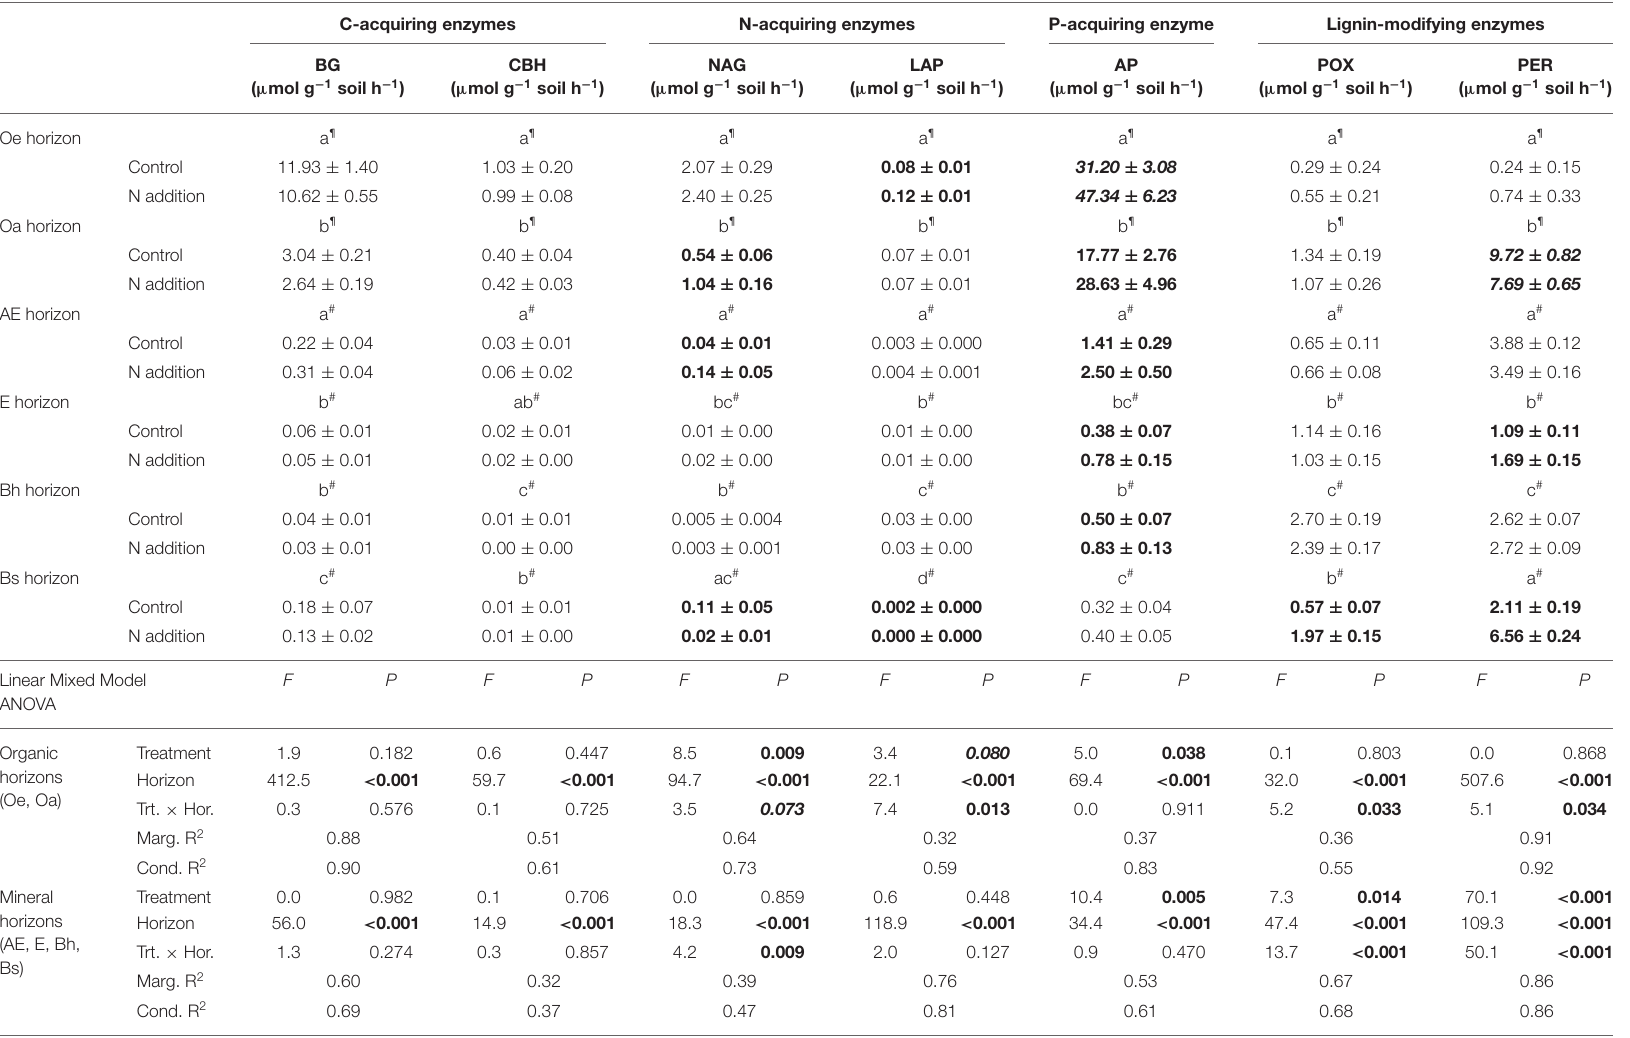
TABLE 6 | Activities of seven soil enzyme classes involved in organic matter decomposition in response to long-term N addition at Klosterhede